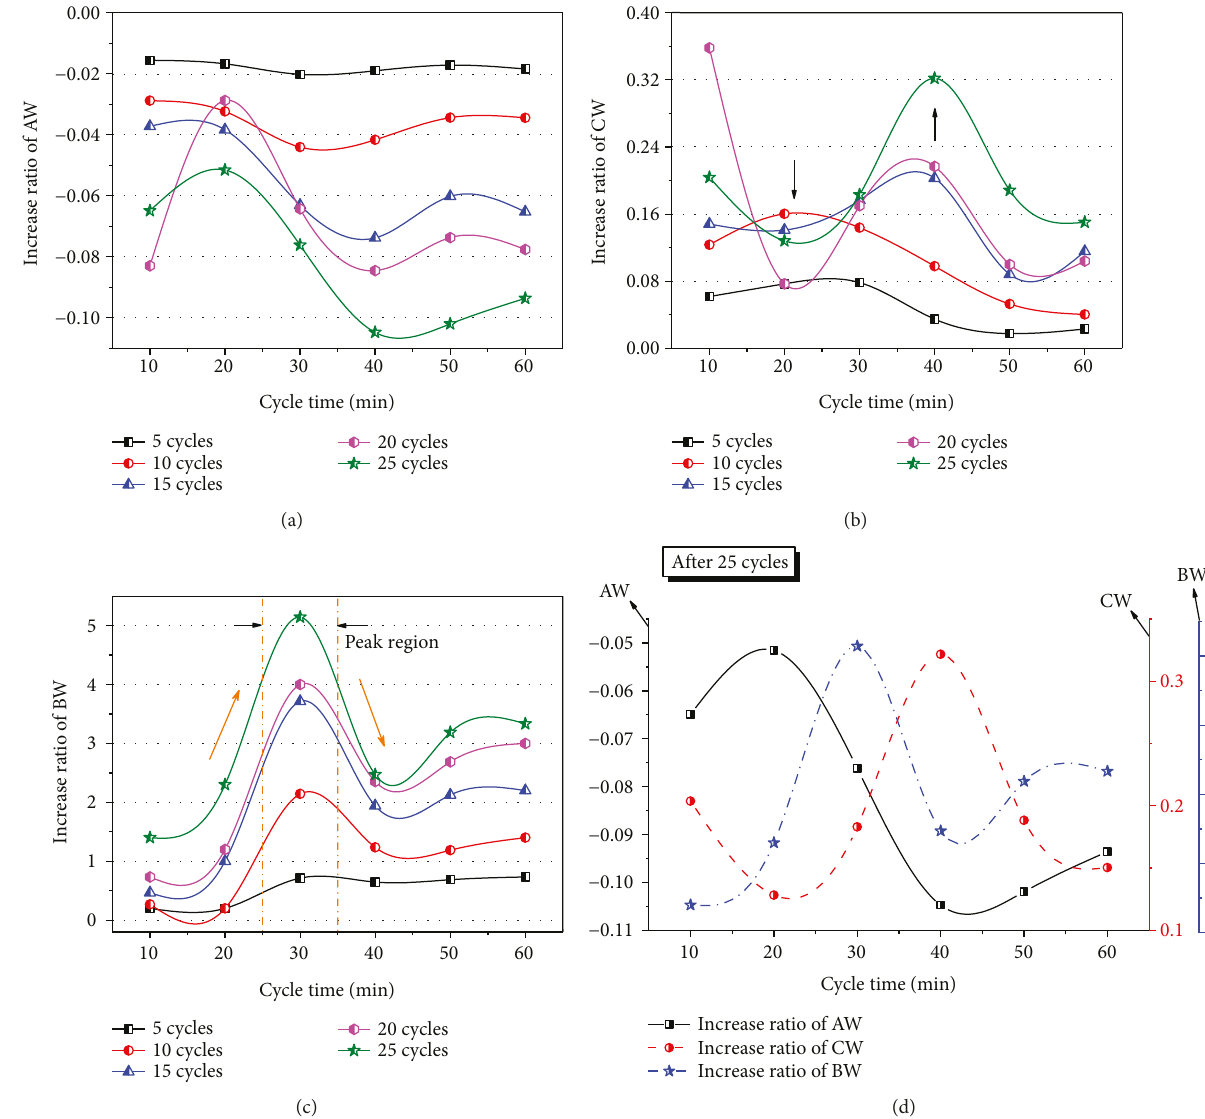
Figure 6: Increase ratio of AW, CW, and BW for six cores after di ff erent cycle time and cycle